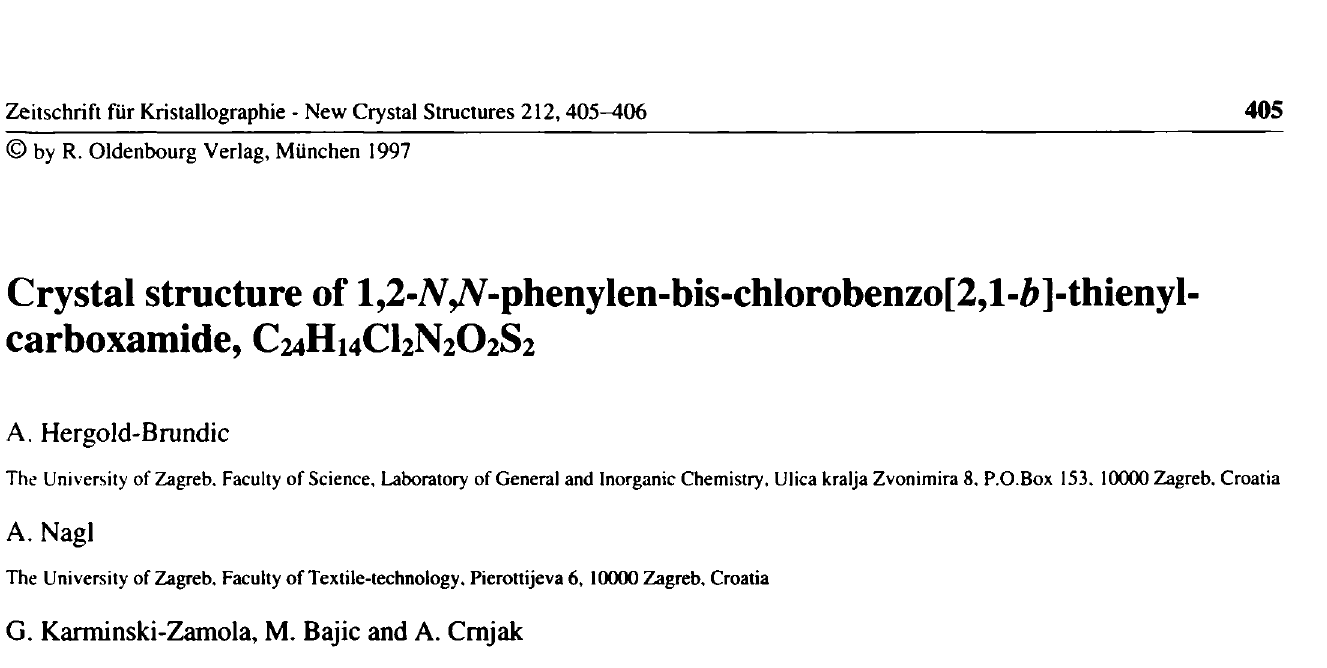
Table 1. Parameters used for the X-ray data collection